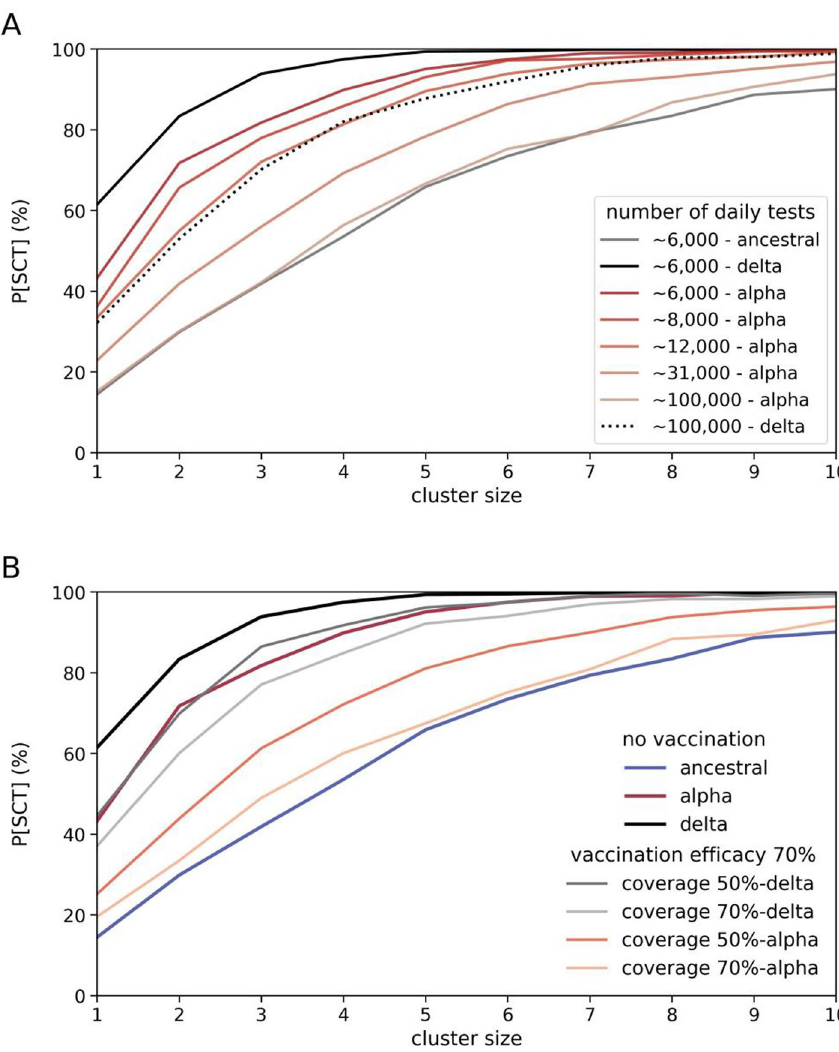
Figure 4. Effects of testing and vaccinations on the probabilities of sustained community transmission (SCT). ( A ) Probabilities of SCT for multiple levels of testing. The dark grey line represents SCT probabilities for ancestral and ∼ 6000 daily tests. The black lines represent SCT probabilities for delta, for ∼ 6000 daily tests (solid line) and ∼ 100,000 daily tests (dotted line). Red-shaded lines are SCT probabilities for the alpha variant and multiple levels of testing. ( B ) Probabilities of SCT for multiple combinations of variant and vaccine coverage, for a vaccine with 70% effectiveness against transmission. The black, dark red, and dark blue lines represent SCT probabilities for delta, alpha and ancestral, respectively, assuming ∼ 6000 daily tests, and no vaccination. The other solid lines are SCT probabilities as a function of vaccine coverage. Gray line 50% vaccinated and delta; light gray line 70% vaccinated and delta; red line 50% vaccinated and alpha; and, light red line 70% vaccinated and alpha. In these scenarios with vaccination, the cluster size represents the number of infections seeded on the first day of the simulated period. All cases have a low Q&I leakage (<